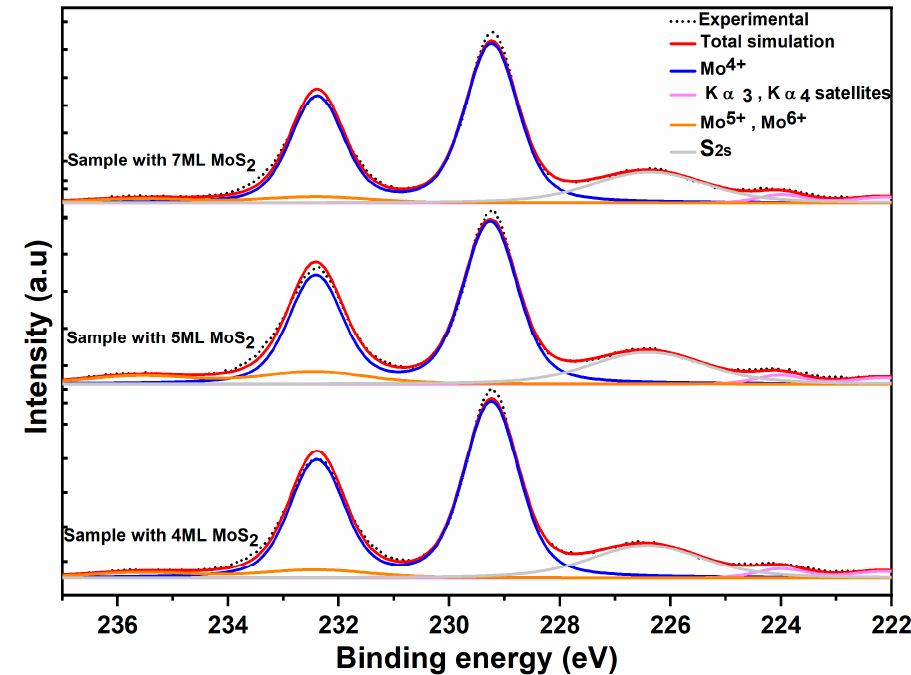
Figure 5. X-ray photoelectron spectroscopy (XPS) performed on samples with 4 ML, 5 ML and 7 ML MoS 2 . The MoS 2 3d core levels are shown.